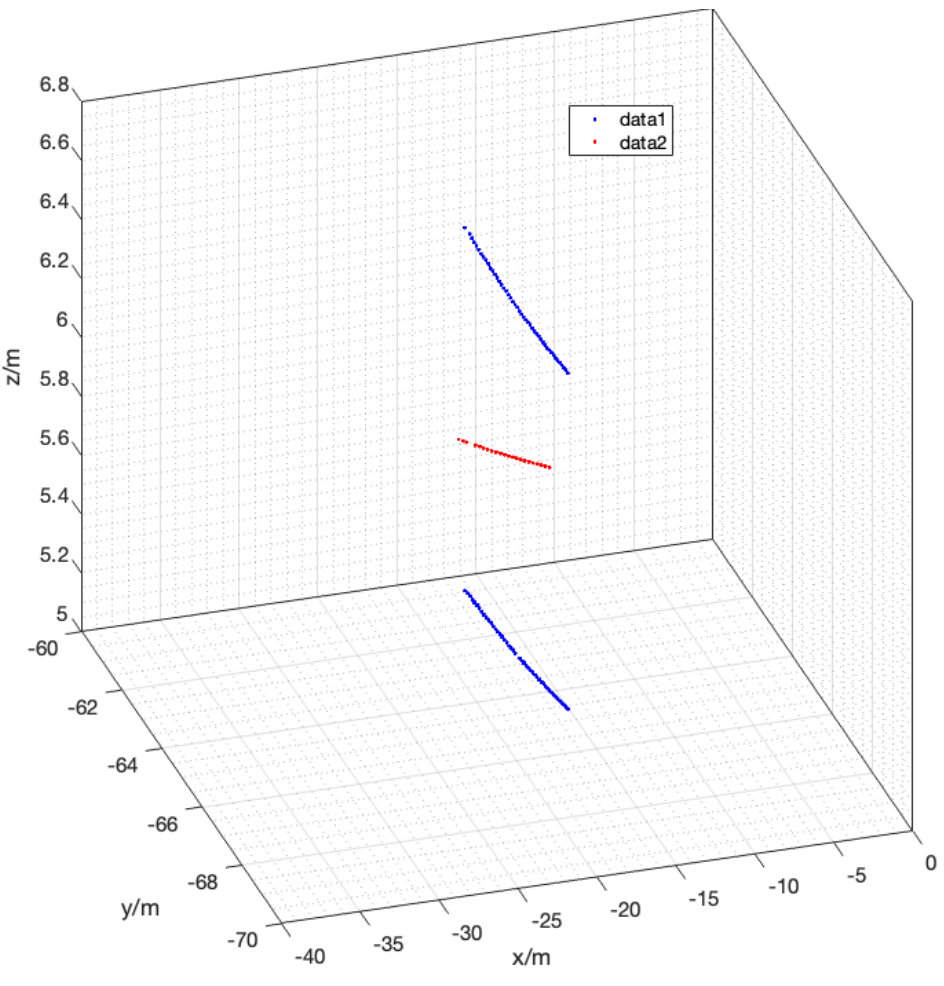
Figure 15. Error in registration.